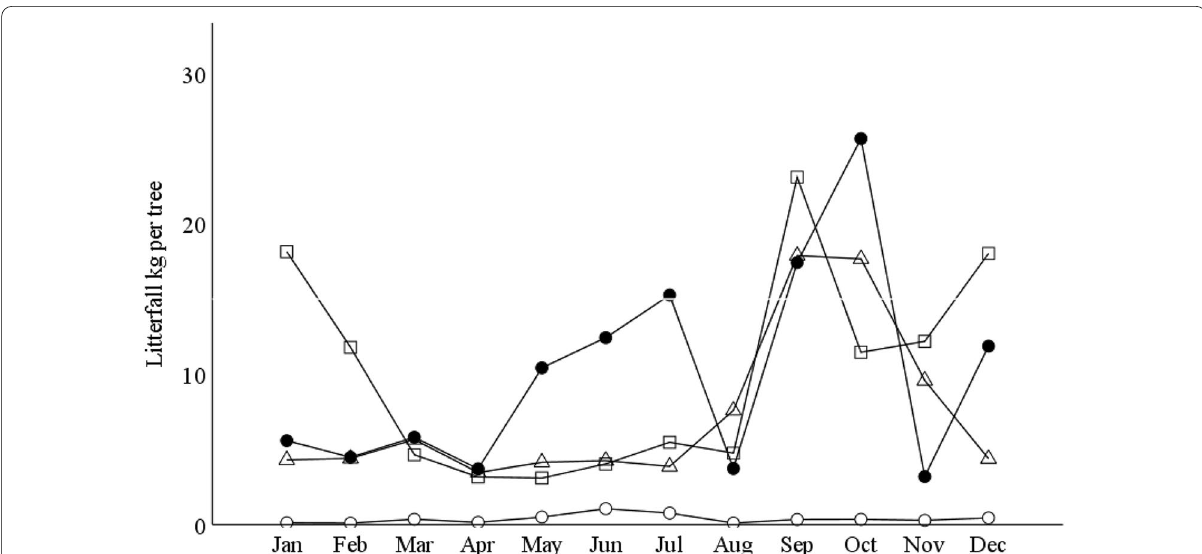
Fig. 4 Monthly variations in leaves litterfall for tree/shrub species in homegarden agroforestry systems in southern and southwestern Ethiopia. Symbols represent: “ ● (filled circle)”— E. brucei ; “ □ (opened squares)”– C. africana ; “∆ (opened triangle)”– G. robusta ; and “ ○ (opened circle)”– M. sylvestris